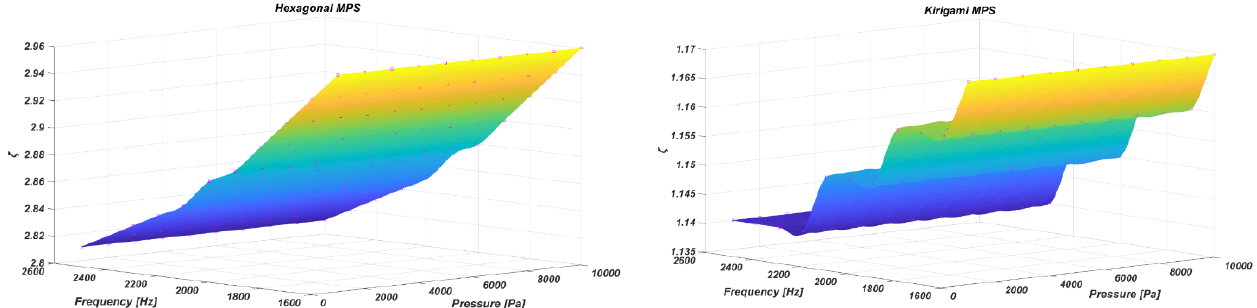
Figure 17. Sensitivity performance against frequency of the three sensor models.